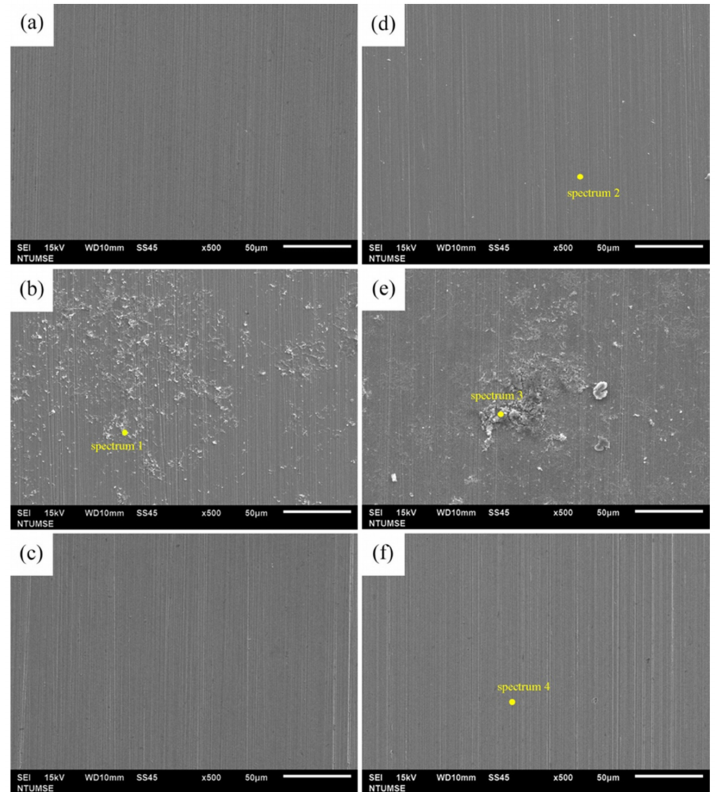
Figure 3. SEM images of the 304SS coupons after different immersion times in various solutions: ( a ) blank for 14 days; ( b ) SRB for 14 days; ( c ) BDMDAC for 14 days; ( d ) blank for 28 days; ( e ) SRB for 28 days; and ( f ) BDMDAC for 28